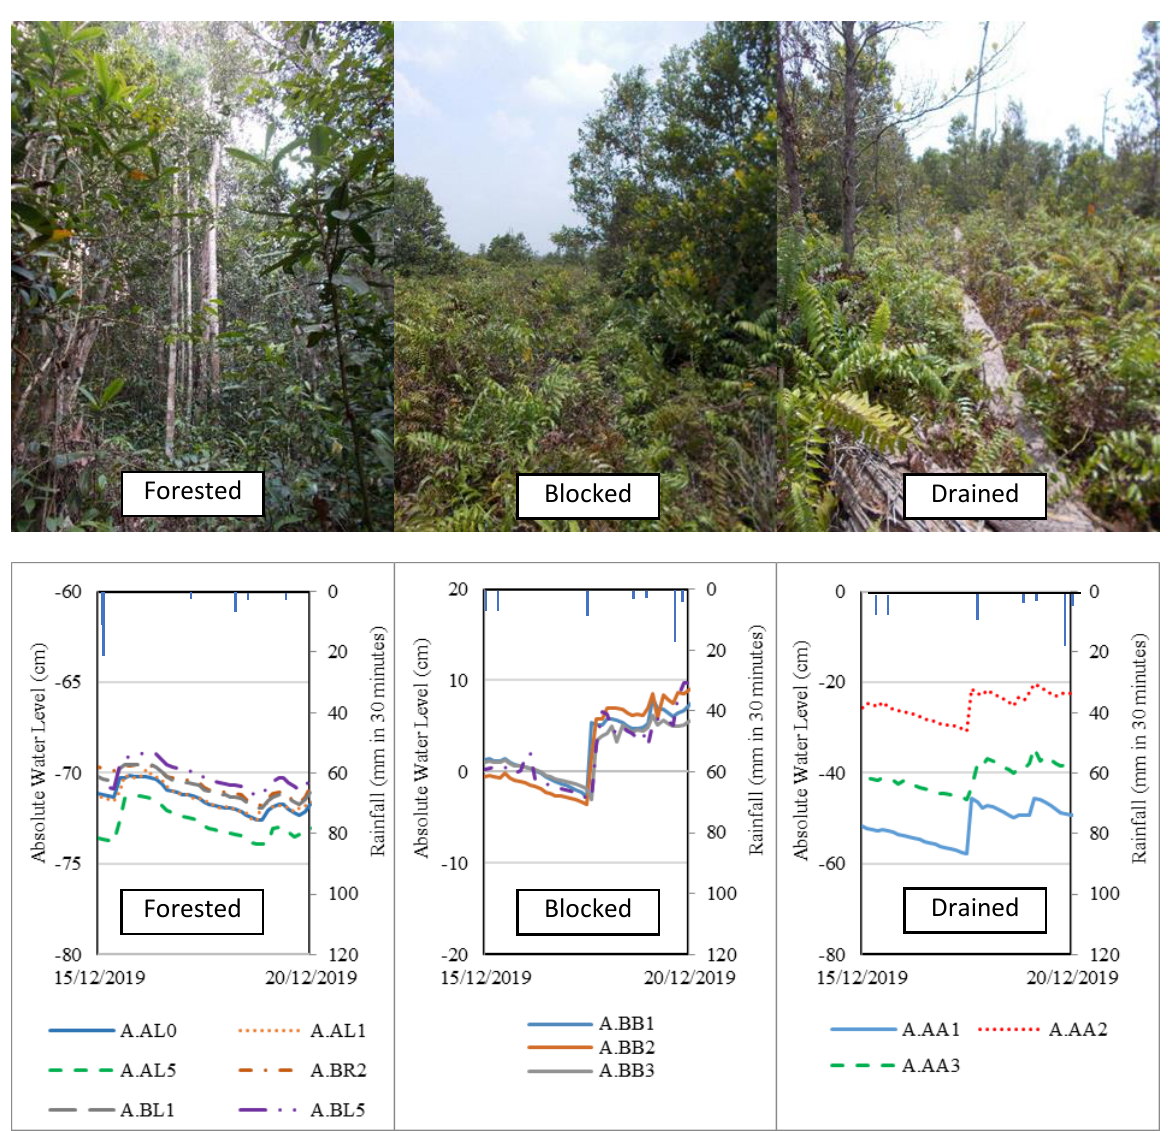
Figure 2. Above: general views across the study sites Forested (08 November 2019), Blocked (18 October 2019) and Drained (03 December 2019). Below: example water-level time series for the period 15–20 December 2019. The water-level time series have different vertical (absolute water-level) scales, based on the benchmarks of Putra et al . (2021). Lines represent automatic logger data and blue bars on the secondary vertical axis are rainfall